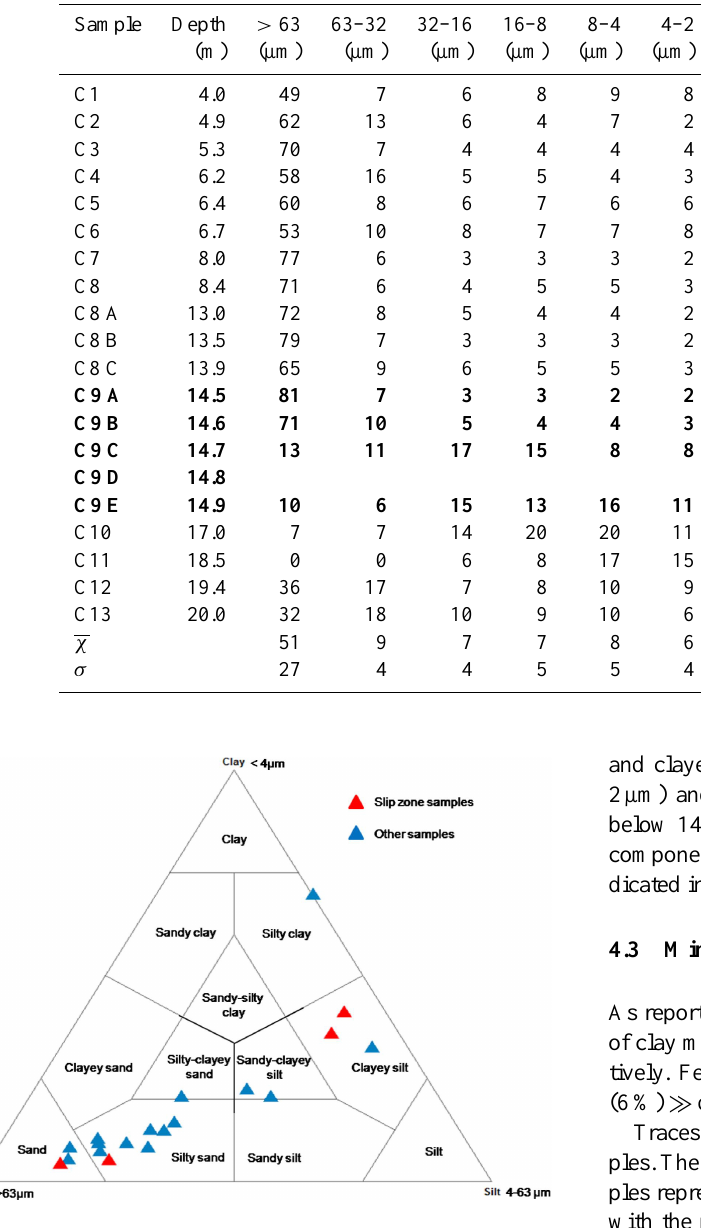
Figure 4. Shepard diagram of the collected